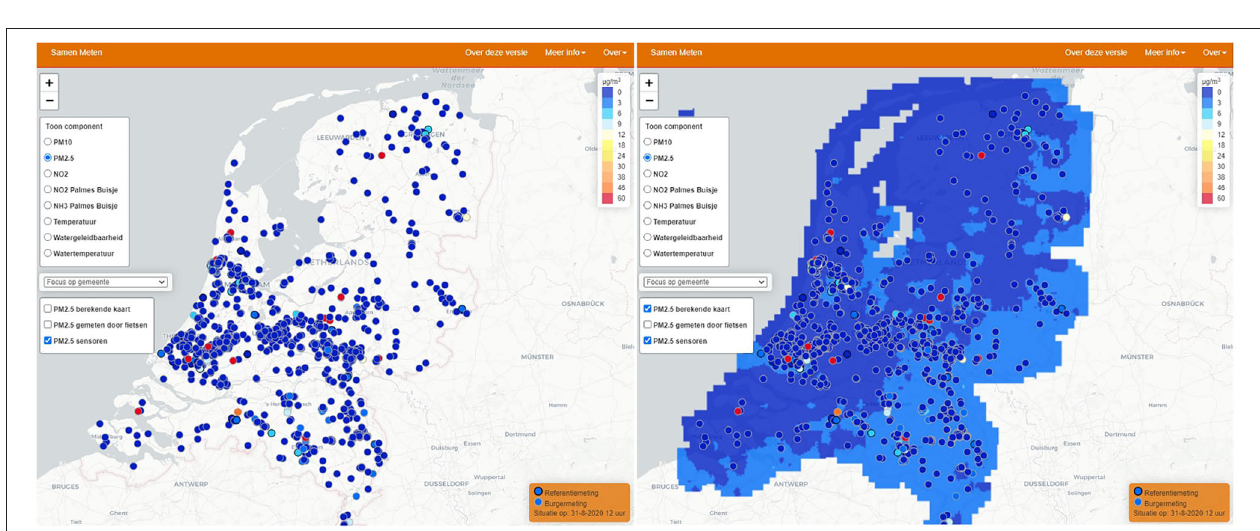
FIGURE 1 | Marine Litter Watch web application including the list of top 10 items collected, with cigarette butts and filters in the first place (A) , and the distribution of events in Europe (B) .